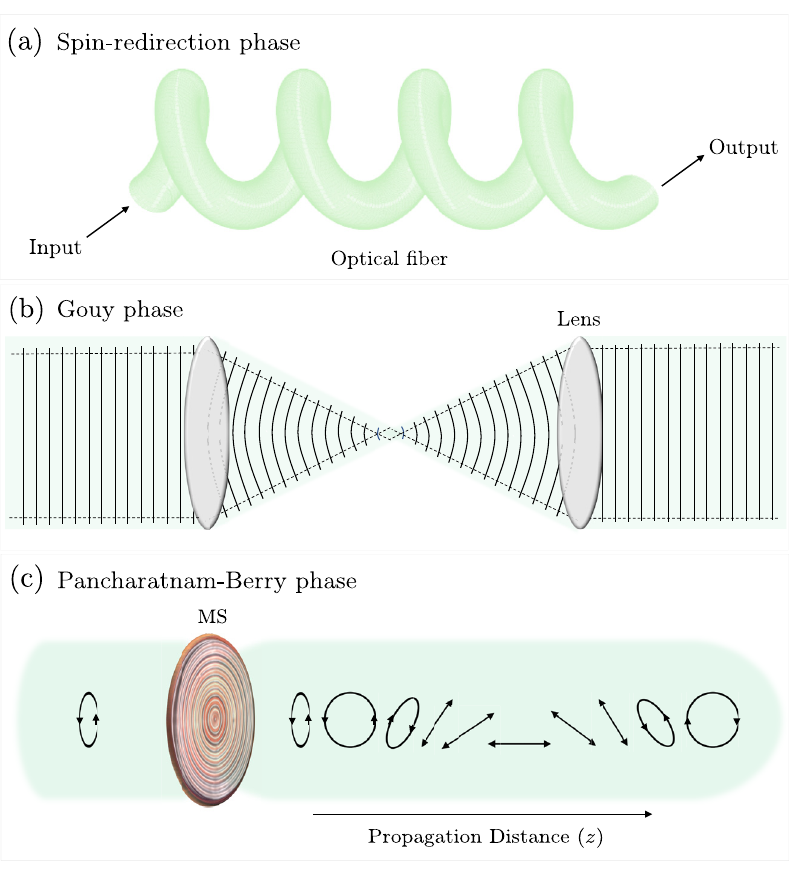
Figure 1: Examples of Berry phase manifes- tations in